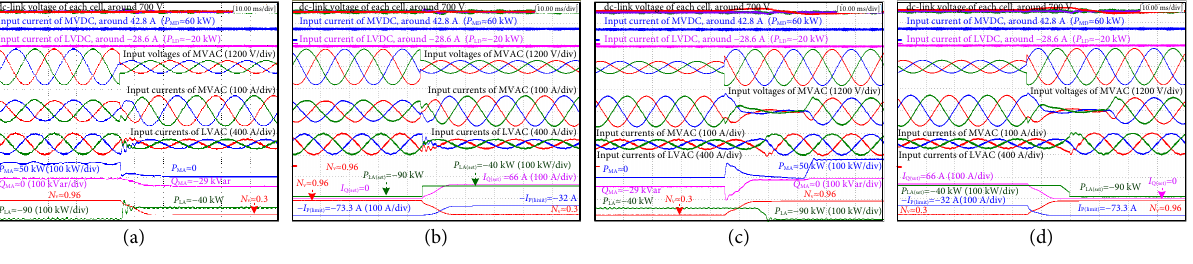
Fig. 24 Experimental results of LVRT Mode-4 in Case-6 of active-power configuration. (a) Real-time power curve in the voltage sag process. (b) Power command curve in the voltage sag process. (c) Real-time power curve in the voltage recovery process. (d) Power command curve in the voltage recovery process.